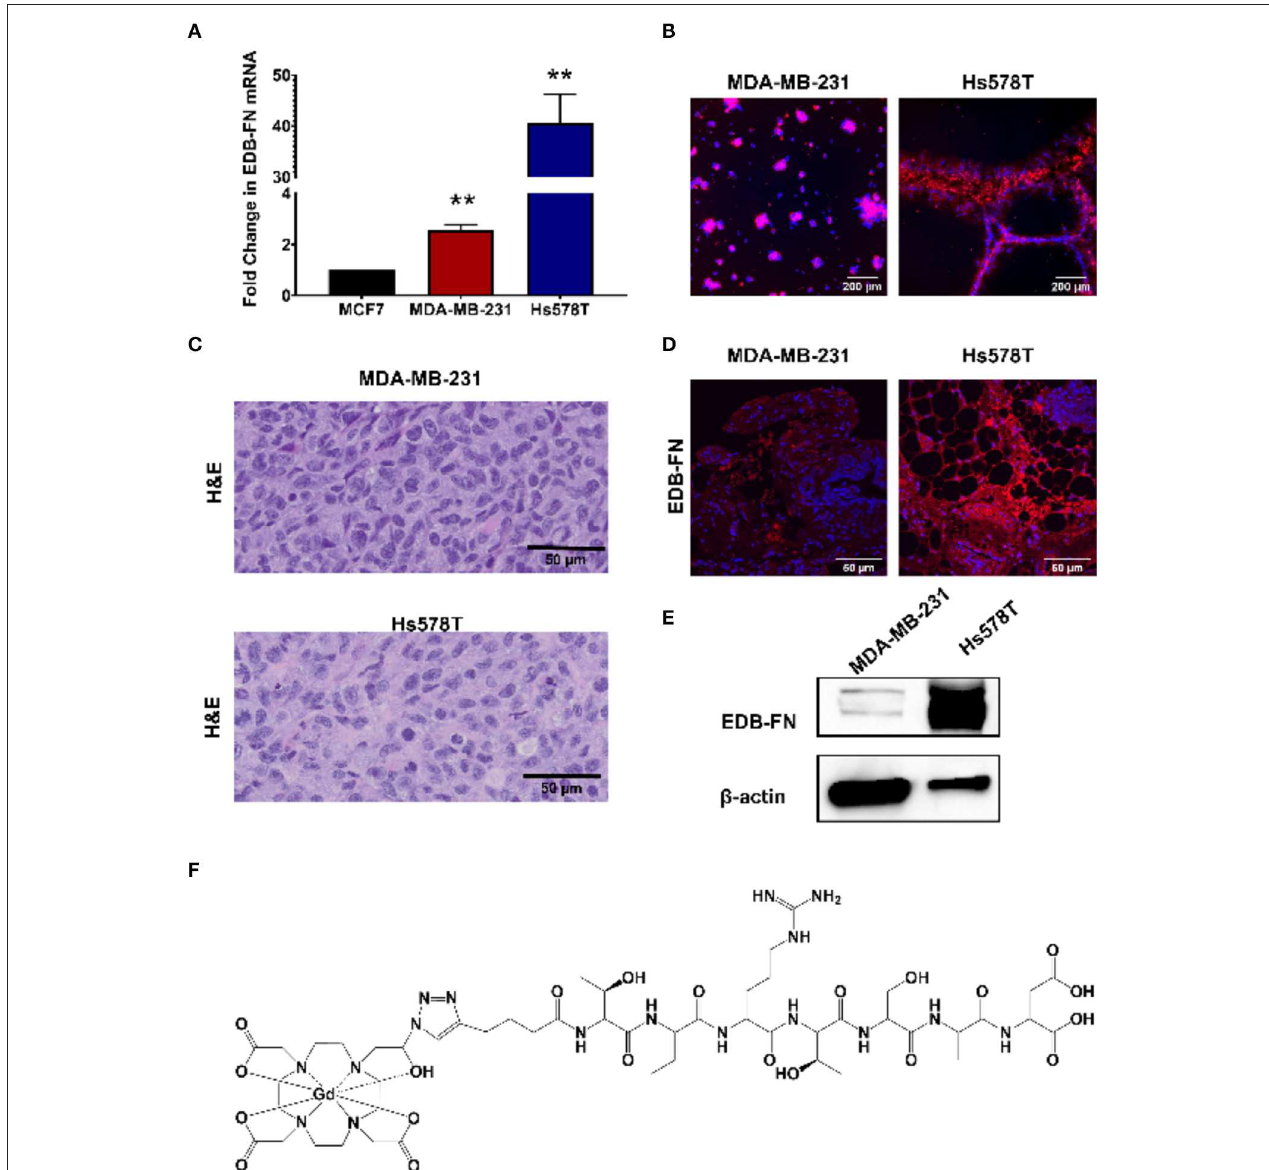
FIGURE 1 | EDB-FN is overexpressed in poorly differentiated, triple negative breast cancer. (A) Endogenous EDB-FN mRNA levels is significantly elevated in triple negative breast cancer cell lines MDA-MB-231 and Hs578T (claudin-low ER − , PR − , HER2 − ) compared to MCF7 (luminal A; ER + ,PR + / − , HER2 − ) [** p < 0.01, (22)]. mRNA was normalized to 18S mRNA control. (B) Representative fluorescence imaging reveals enhanced ZD2-Cy5.5 (red) binding in 3D cultures of MDA-MB-231 and Hs578T cells. (C) H&E staining of MDA-MB-231 and Hs578T tumor sections. Scale bar: 50 µ m. (D) Analysis of EDB-FN expression in MDA-MB-231 and Hs578T tumor sections. Scale bar: 50 µ m (E) Western blot analysis of EDB-FN expression in MDA-MB-231 and Hs578T tumors. β -actin was used as a loading control. (F) Chemical structure of ZD2-N3-Gd(HP-DO3A) (MT218).